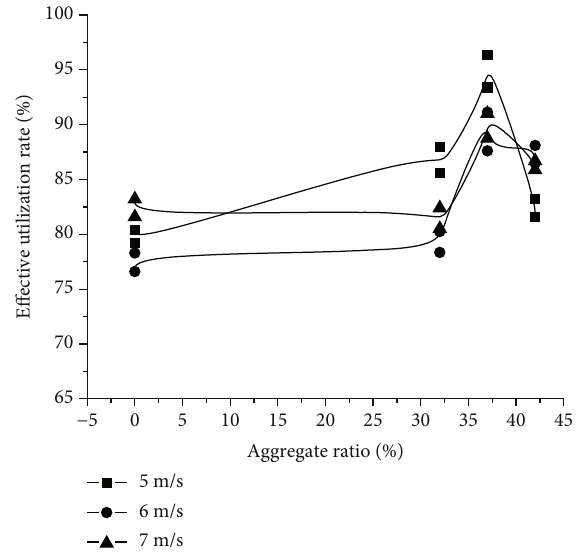
Figure 12: The relationship between the e ff ective utilization rate of energy absorption of the specimens and the aggregate rates.